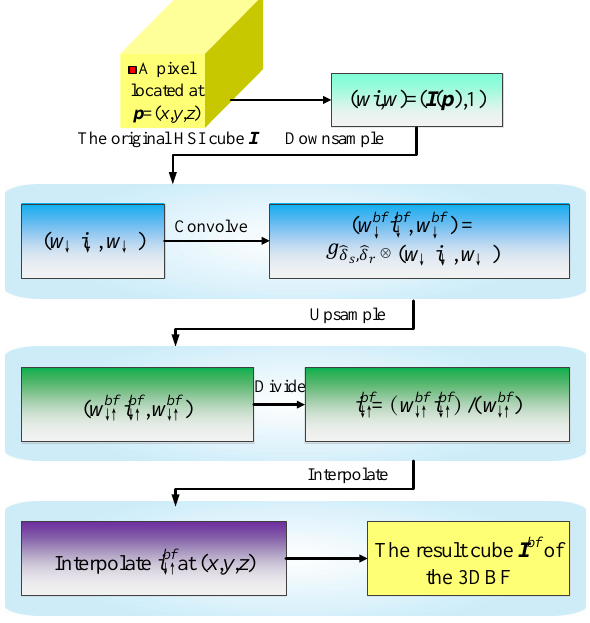
Figure 2. Schematic diagram of the